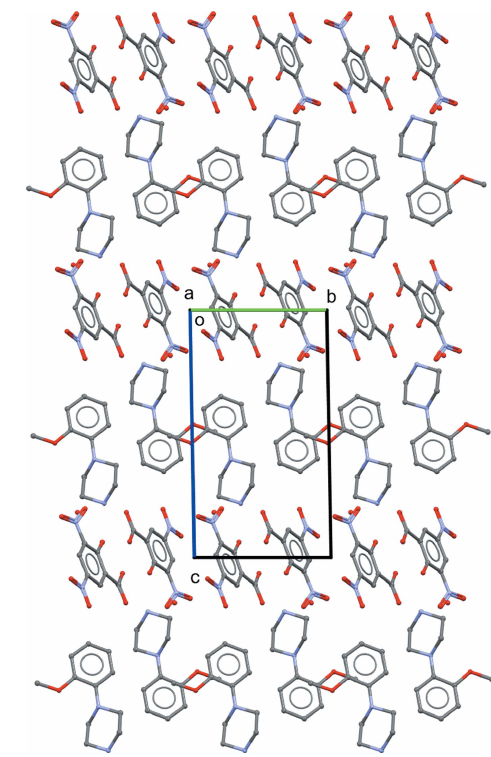
Figure 6 Overall packing diagram for the title salt